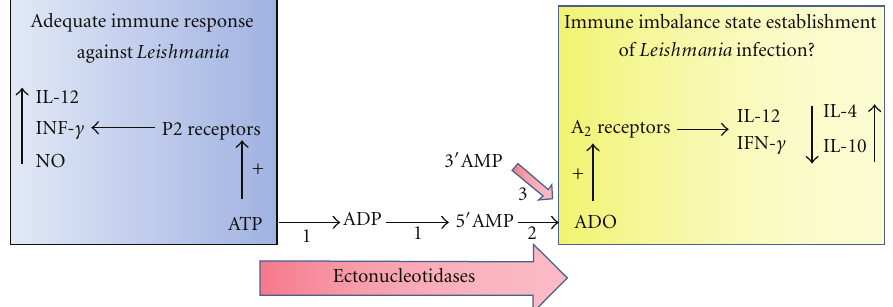
Figure 1: Partial reactions catalyzed by ecto-nucleoidases: (1) ecto-ATPase, ectonucleoside triphosphate diphosphohydrolase; (2) ecto-5 (cid:2) - nucleotidase; (3) ecto-3 (cid:2) -nucleotidase. The sequential hydrolysis of extracellular ATP by Leishmania ectonucleotidases triggers the host inflammatory and immune response following P2 receptor activation by extracellular ATP (blue square) and P1 (A 2 ) receptors activation by extracellular adenosine nucleoside (yellow square). ADO: